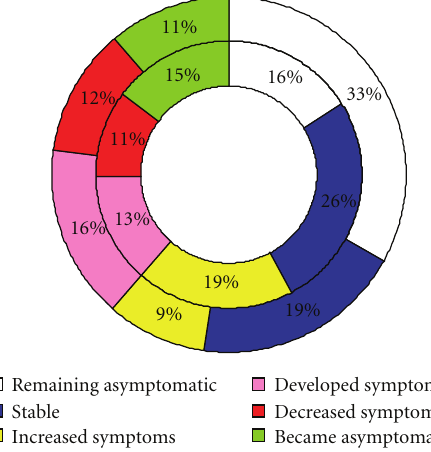
Figure 6: Six-group transition model, change from initial to the final survey. Women with dysmenorrhea ( n = 130) in the inner circle and women without dysmenorrhea ( n = 163) in the outer circle.